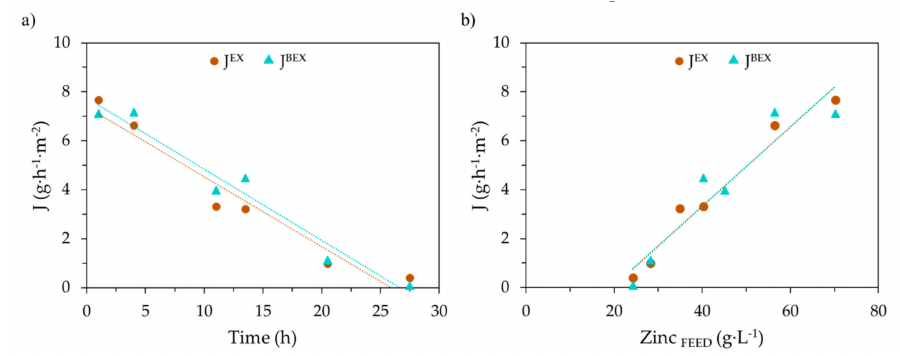
Figure 7. Zn flux, calculated from extraction ( J EX ) and backextraction ( J BEX ) data of EXP III. ( a ) J EX , J BEX evolution with time; ( b ) J EX , J BEX as a function of zinc concentration in the feed phase. Zinc flux values in Figure 7a calculated form EX and BEX data show a linear evolution with time.